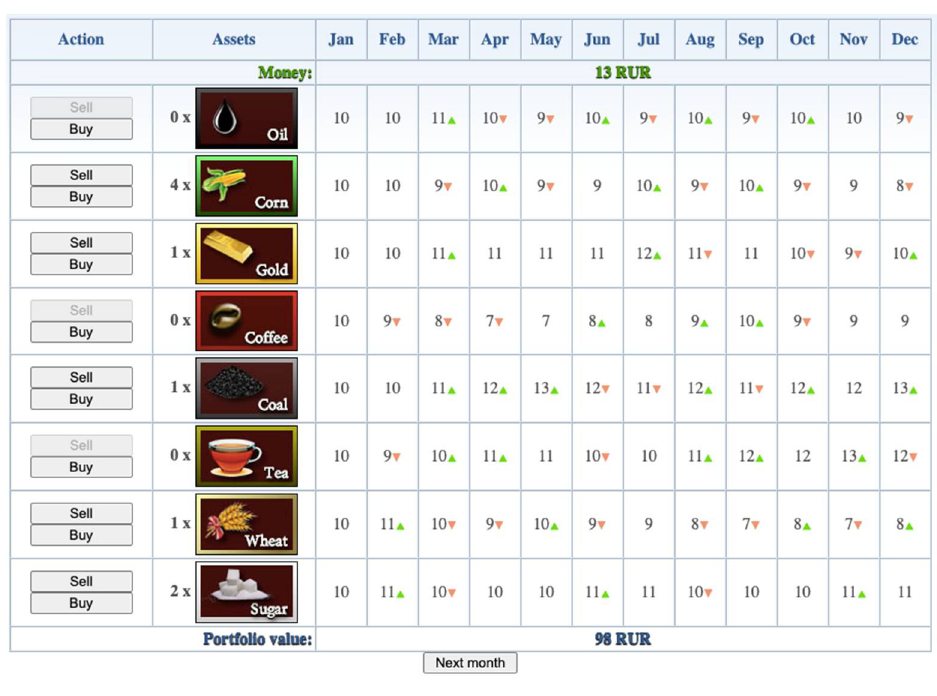
Figure 1. Familiar experimental portfolio at the end of the first session.